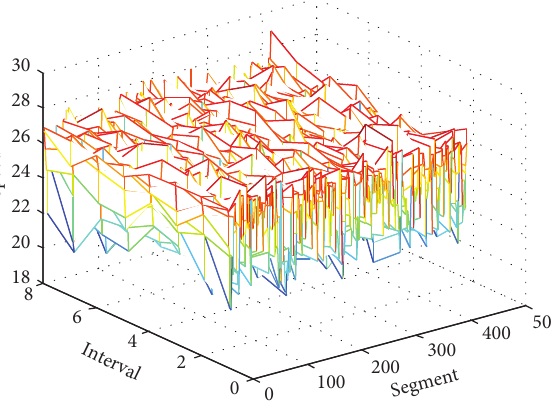
Figure 7: Speed on each segment per interval when demand is